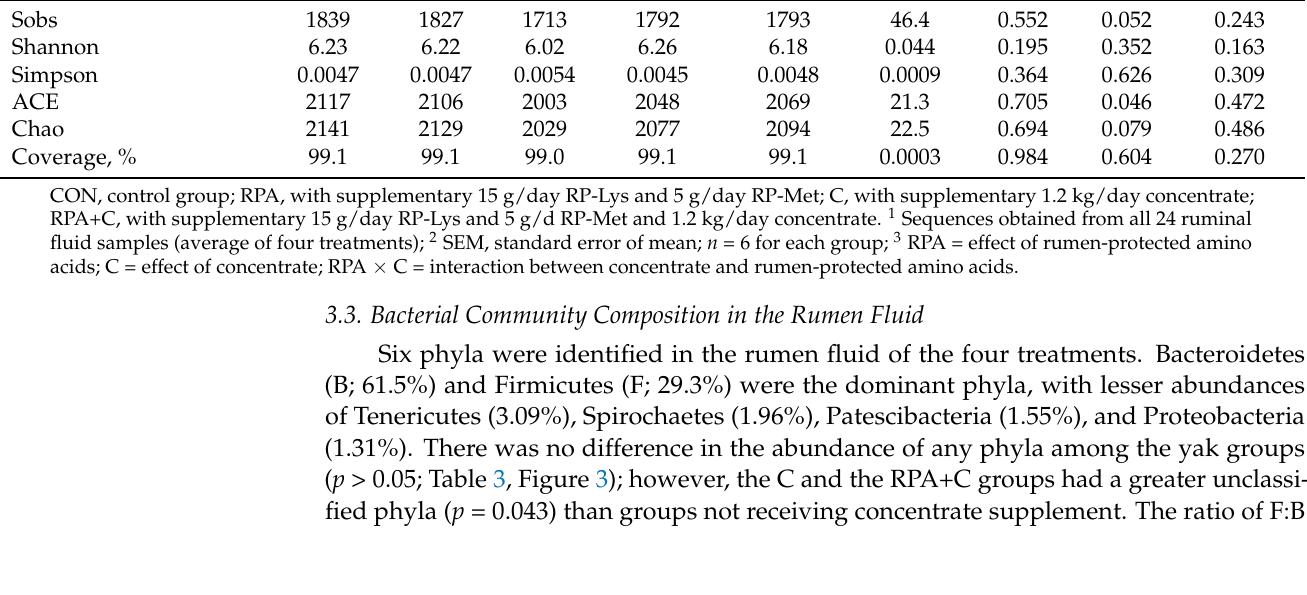
Table 2. Effect of supplementary feeds on alpha diversity of rumen bacteria in grazing, lactating yaks. Alpha Diversity